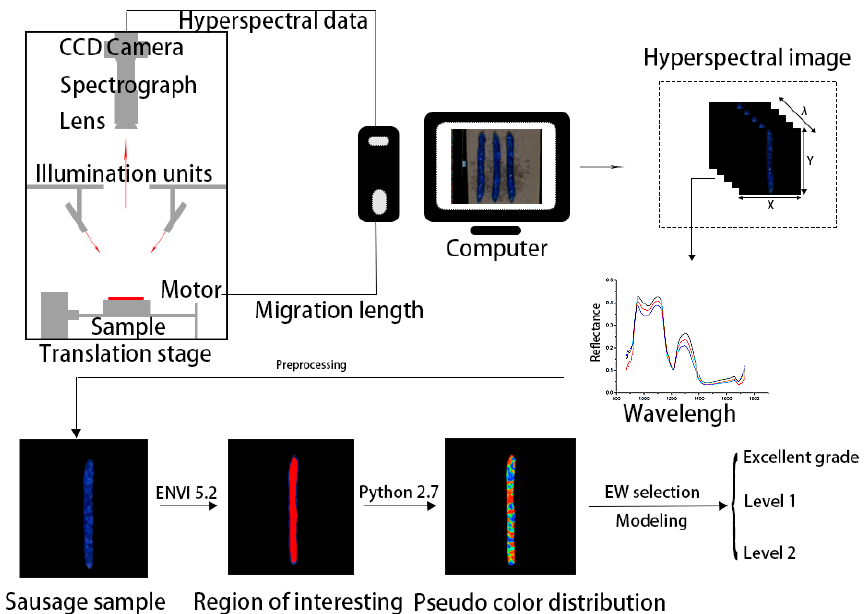
Figure 1. The flow chart of hyperspectral detection and image processing; The CCD camera was located at the top of the translation stage, through which the sausage hyperspectral image was acquired and transmitted to the computer. Then ENVI was used to visualize hyperspectral images and extract ROI (region of interesting). Finally, Python 2.7 was used to select effective wavelengths (EW) and model